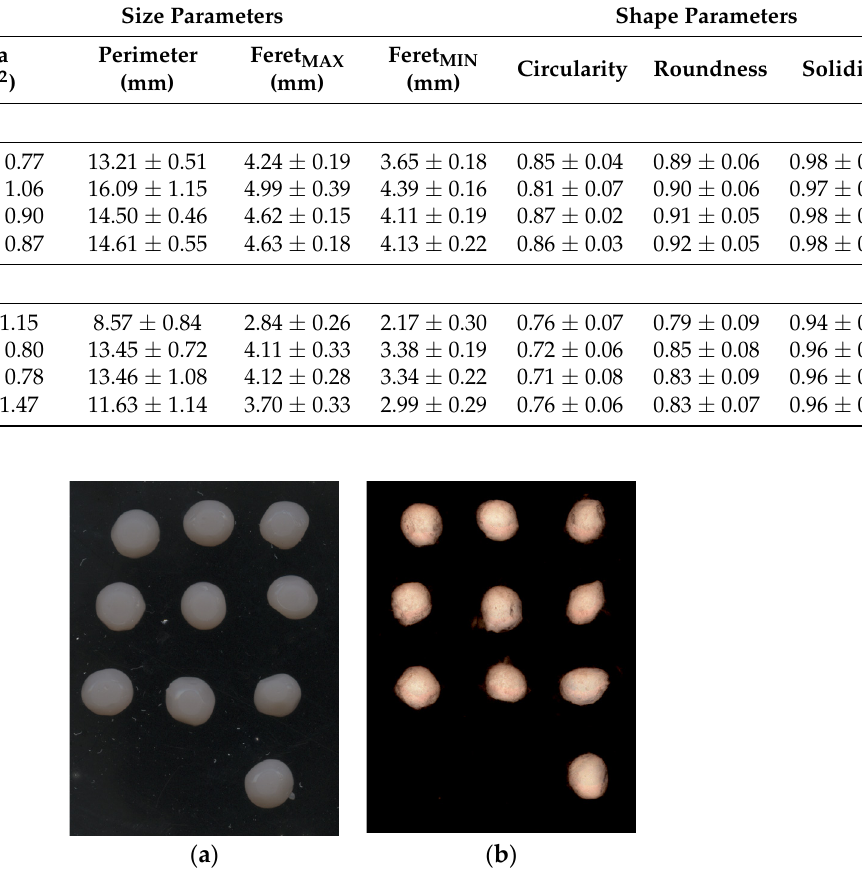
Figure 2. ( a ) Hydrogels and ( b ) freeze-dried microbeads prepared with sodium alginate and gelatin.